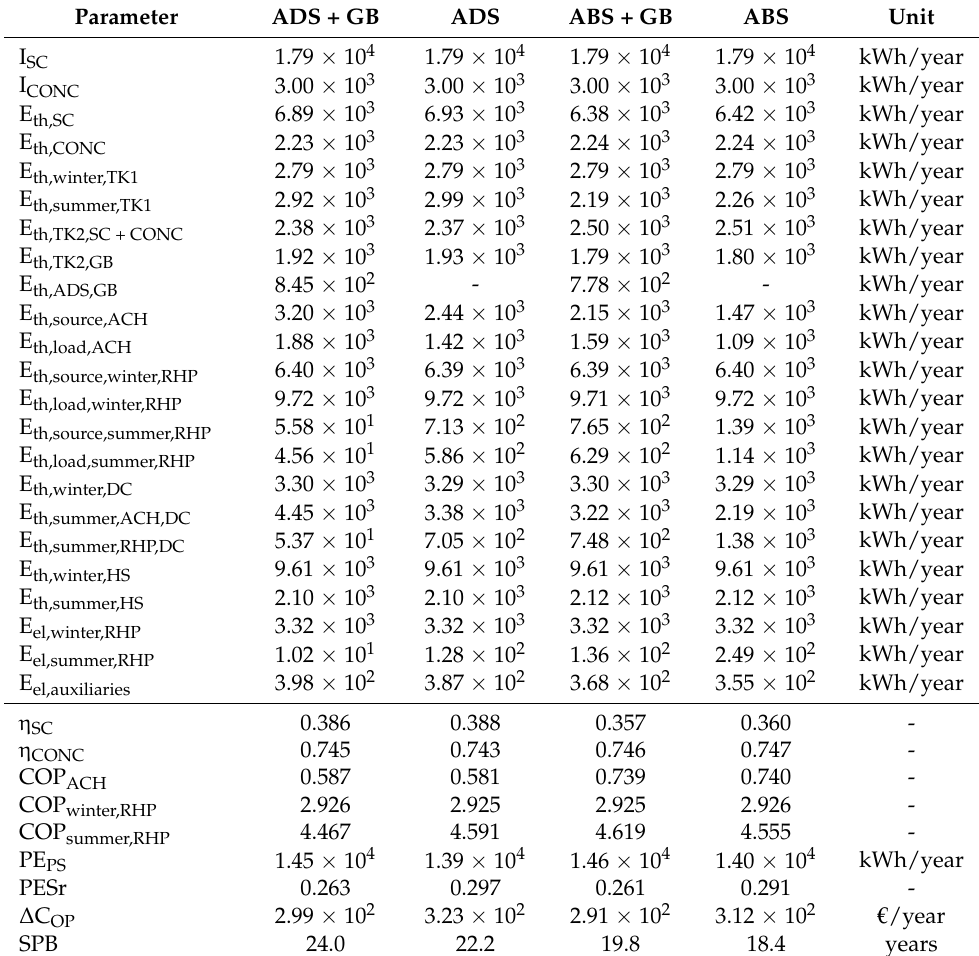
Table 5. Yearly results for Cracow location.